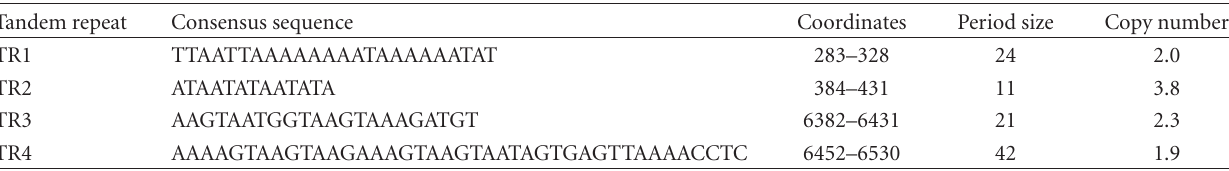
Table 2: Tandem repeats in pPO1.